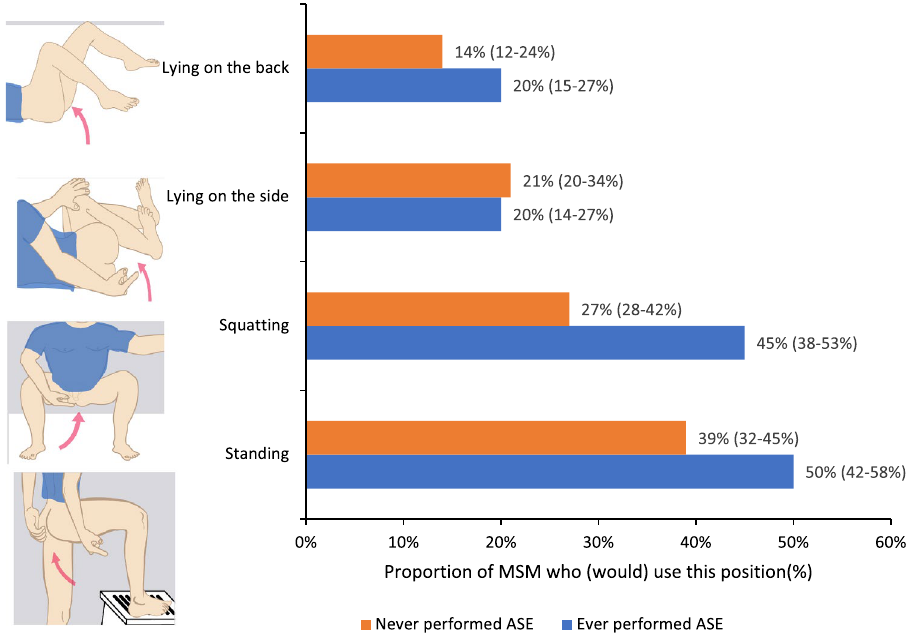
Figure 1. Positions used by MSM who had ever performed ASE and positions likely to be used by MSM who had never performed ASEs. Multiple positions were selected, and the total will exceed 100%. The choices were not mutually exclusive. 95% confidence interval expressed in brackets following the proportion. Note: 176 men who had ever performed ASE and 227 who had never performed ASE answered questions on sexual positions. Six men in the ever-performed ASE chose other positions. Other positions were not asked in the never performed ASE group. This category was not included in the graph.